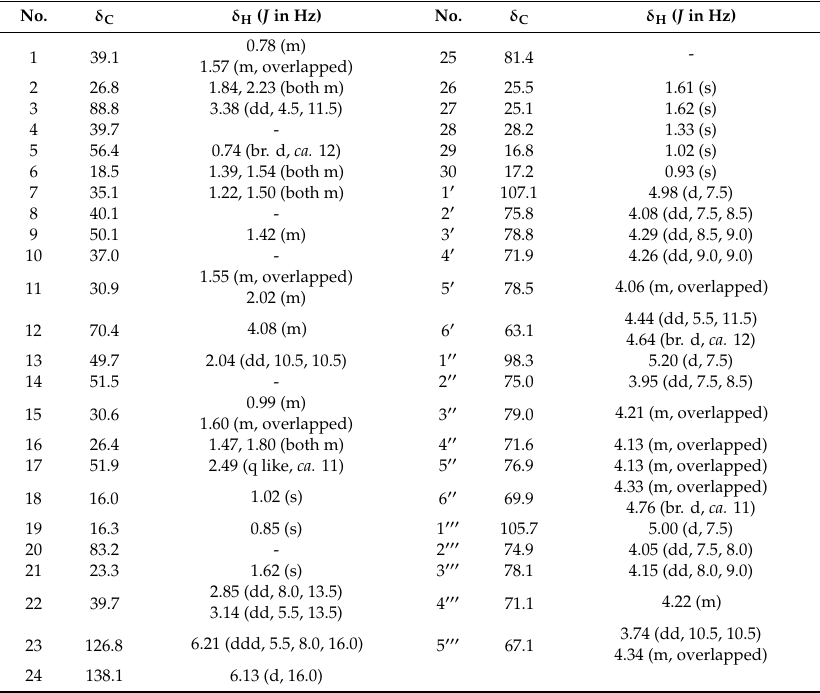
Table 2. The 1 H and 13 C-NMR data for 2 in C 5 D 5 N.